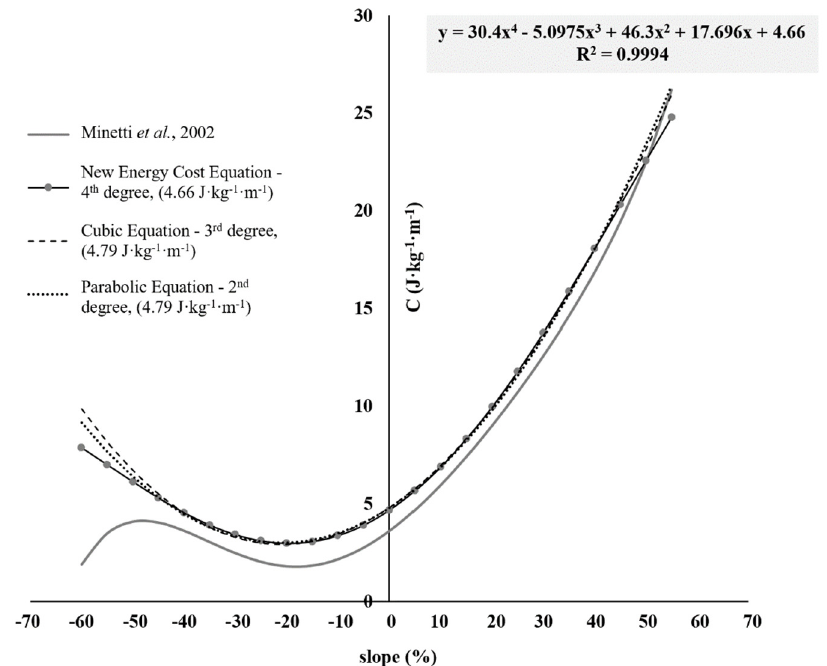
Figure 2. New energy cost paradigm (4th order polynomial fit) relating to the C of running over grass in elite soccer as a function of the gradient with initial C r constant at 0% equivalent to 4.66 J · kg − 1 · m − 1 . Where y = energy cost; x = gradient (%): y = 30.4x 4 − 5.0975x 3 + 46.3x 2 + 17.696x + 4.66 (new energy cost equation).